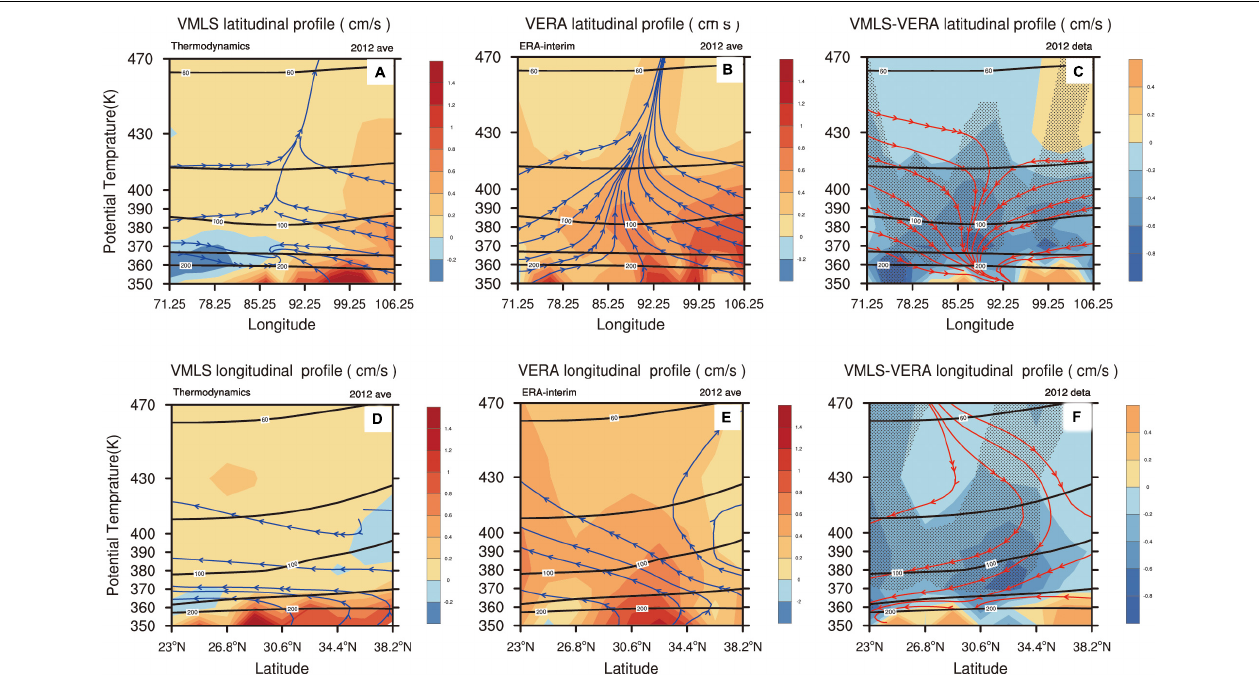
FIGURE 5 | Daily mean V MLS (A,D) , V ERA − I (B,E) and the deviation between them (C,F) for daytime in JJAS 2012. Panels (A–C) are the latitudinal profiles along 80.5 ◦ E and (D–F) are the longitudinal profiles along 32.5 ◦ N. The shading represents the vertical velocity field, the streamlines are the vertical and horizontal wind fields and the contour lines are the air layer. The dotted regions in panels (C,F) represent the area that passed the 95% significance test.